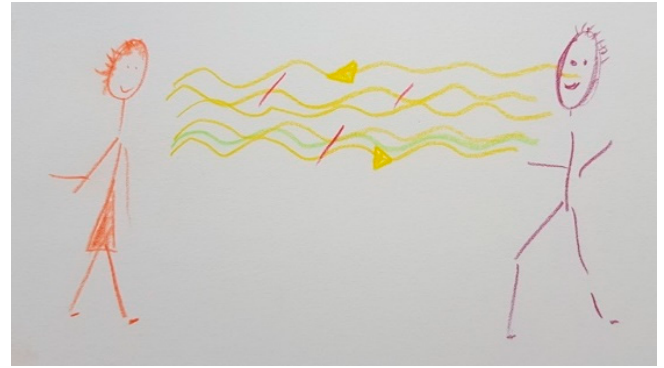
Figure 13. FC6’s perception of DBS’s effect.